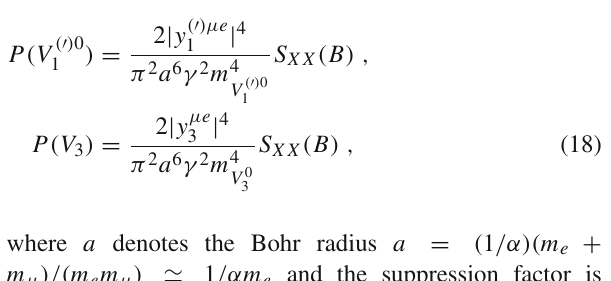
thescatteringangle (cid:14) cos θ (cid:15) (cid:12) 1 / 2.Thislimitdoesnotapplyfor H 2 with non-degenerate neutral scalars m h